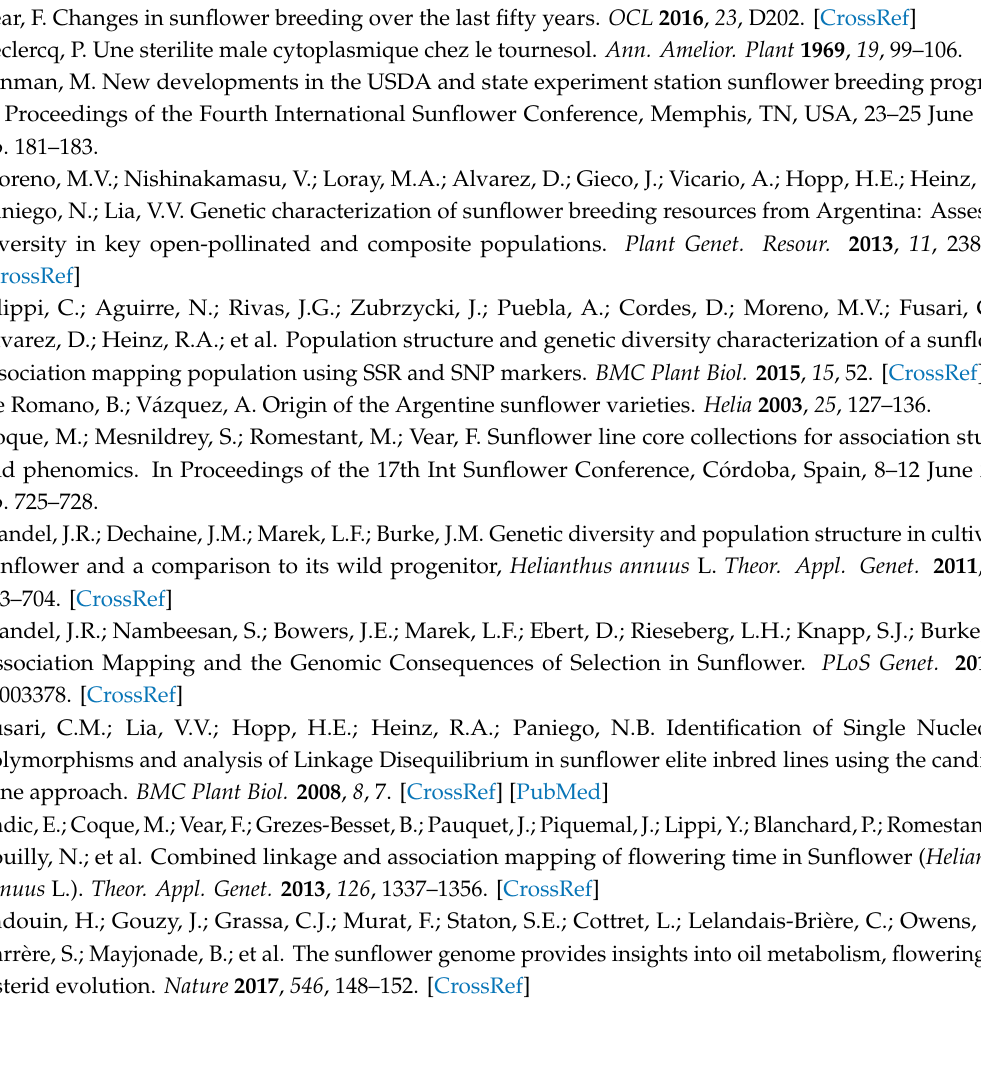
(IBD) measures. Table S3: Percentage of accessions assigned to each group using DAPC or STRUCTURE clustering methods that were clustered together in the dendrogram. (A) DAPC; (B) STRUCTURE. Table S4: Linkage disequilibrium statistics between and within breeding